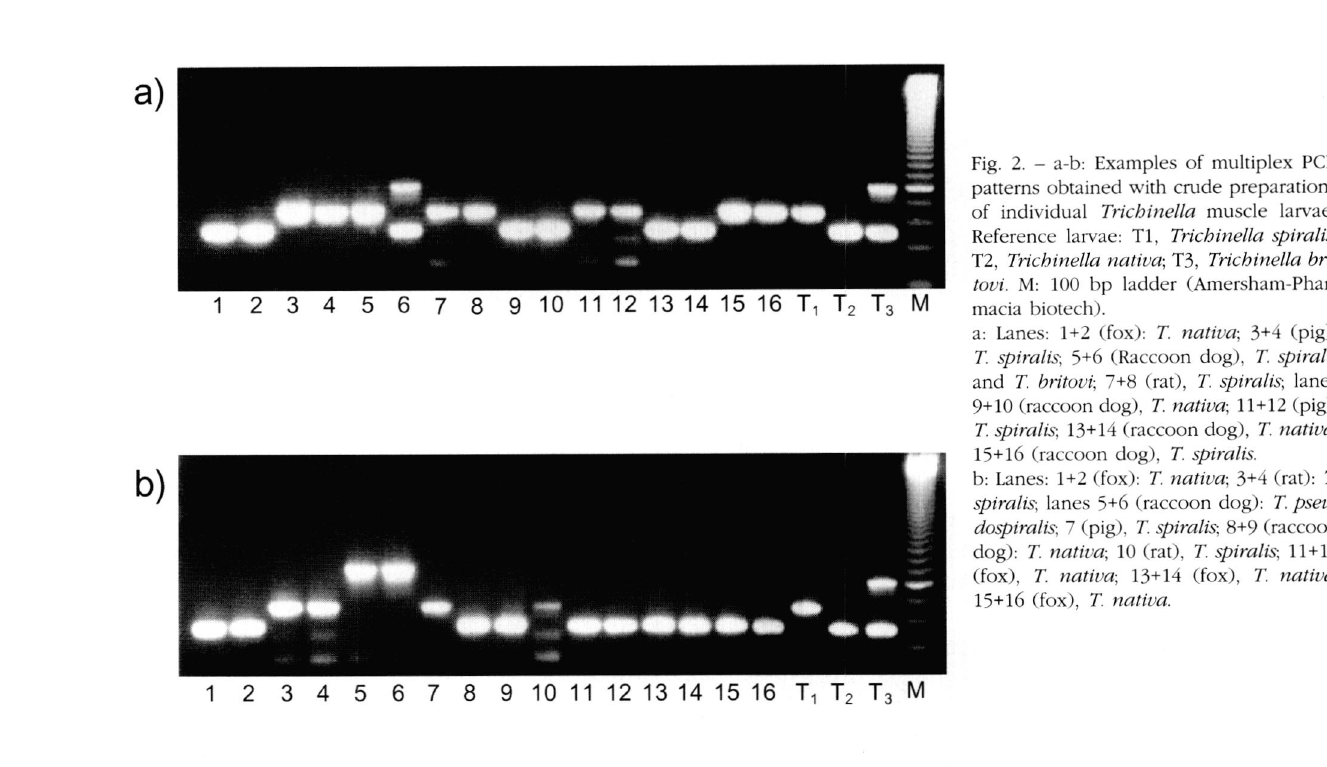
Fig. 2. - a-b: Examples of multiplex PCR patterns obtained with crude preparations of individual Trichinella muscle larvae. Reference larvae: T1, Trichinella spiralis; T2, Trichinella nativa; T3, Trichinella bri- tovi. M: 100 bp ladder (Amersham-Phar- macia